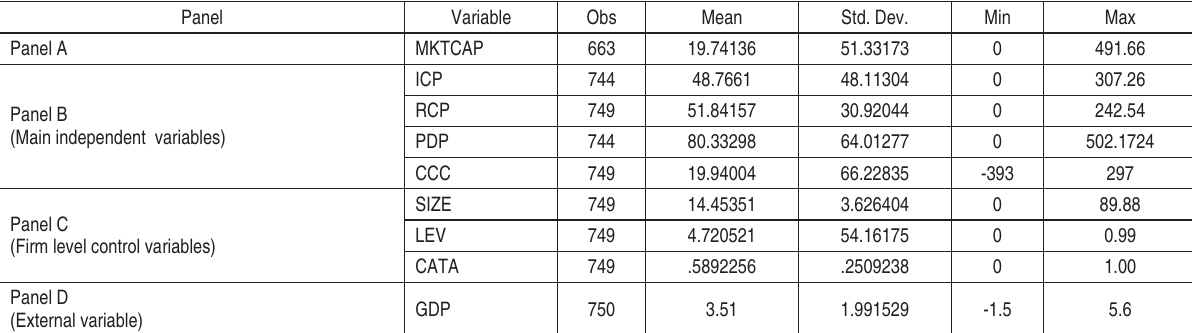
Table 3. Descriptive statistics for dependent and independent